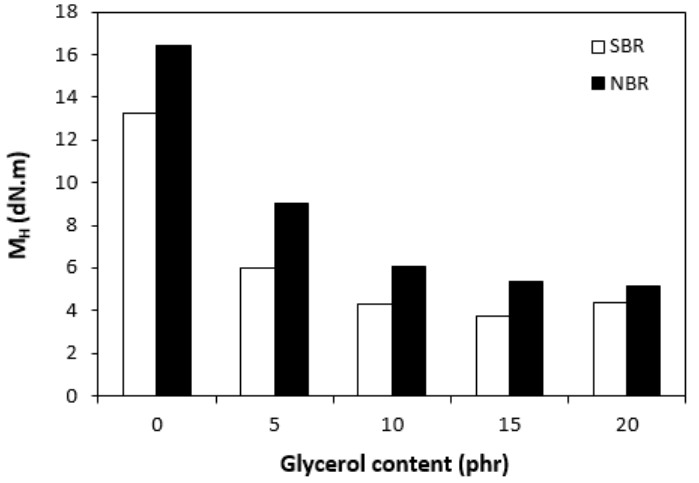
Figure 5. Influence of glycerol content on maximum torque (M H ) of rubber compounds.